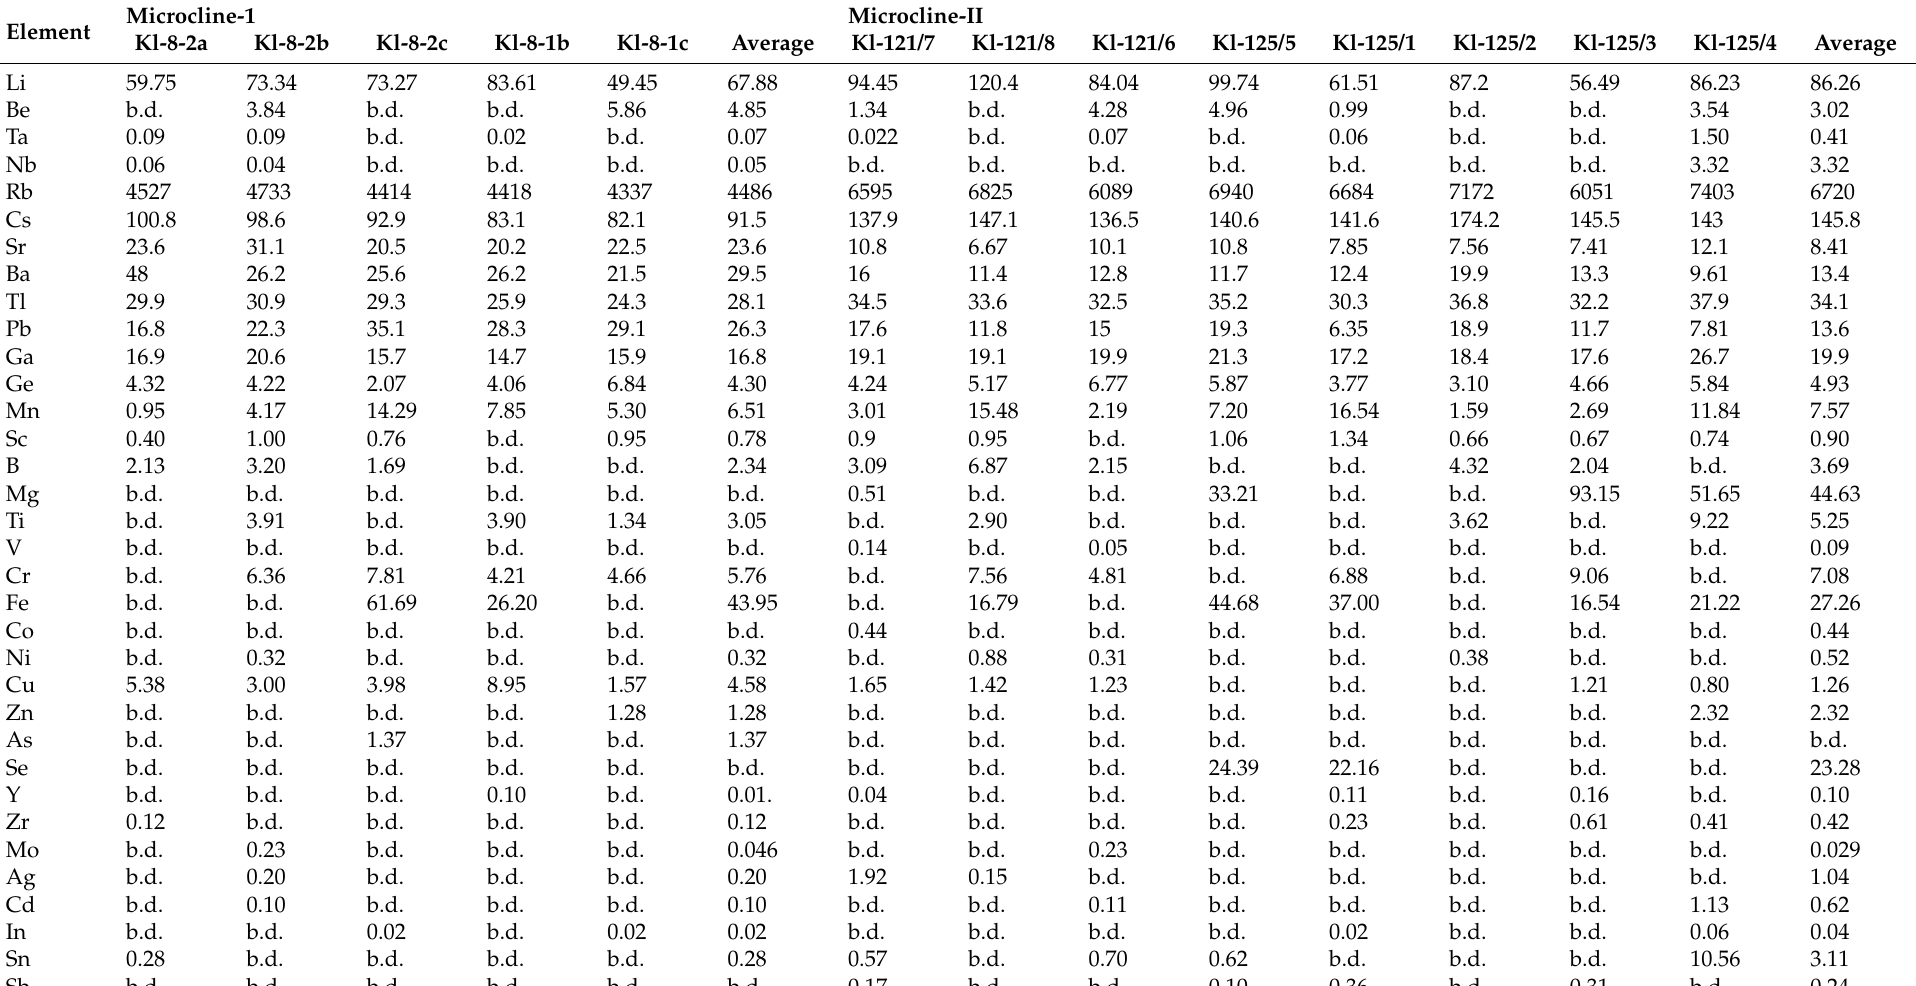
Table 2. Minor and trace elements in the K-feldspar from highly fractionated albite-spodumene pegmatites (ppm) determined by